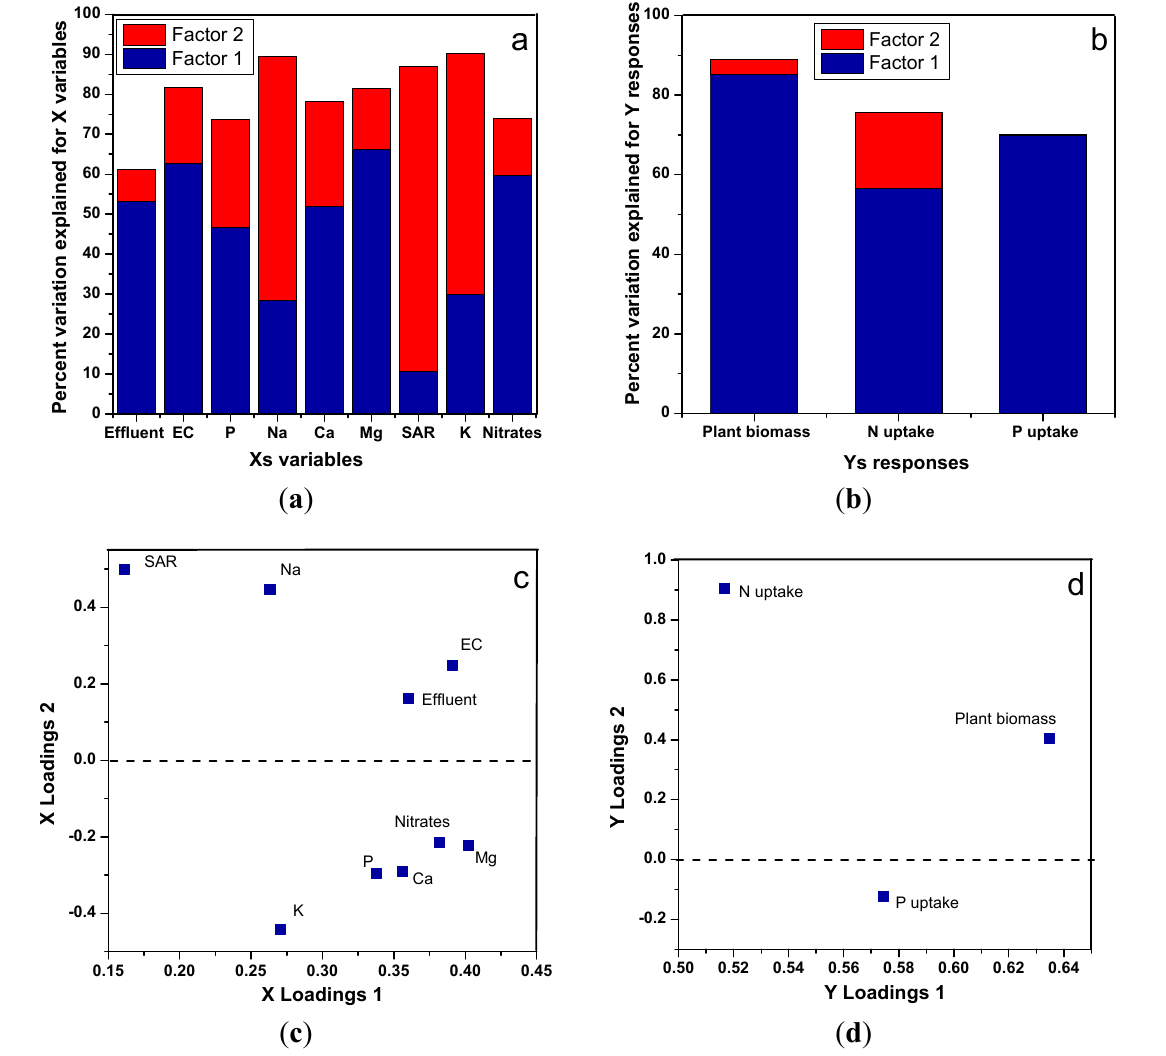
Figure 1. Explained variation and factor loadings for X variables ( a , c ) and Y responses ( b , d ). The amount of the effluent, EC, nitrates and Mg 2+ were among the most powerful X variables in the determination of PLSR model (Figure 2). Based on 0.8 threshold two X variables (SAR and K + )